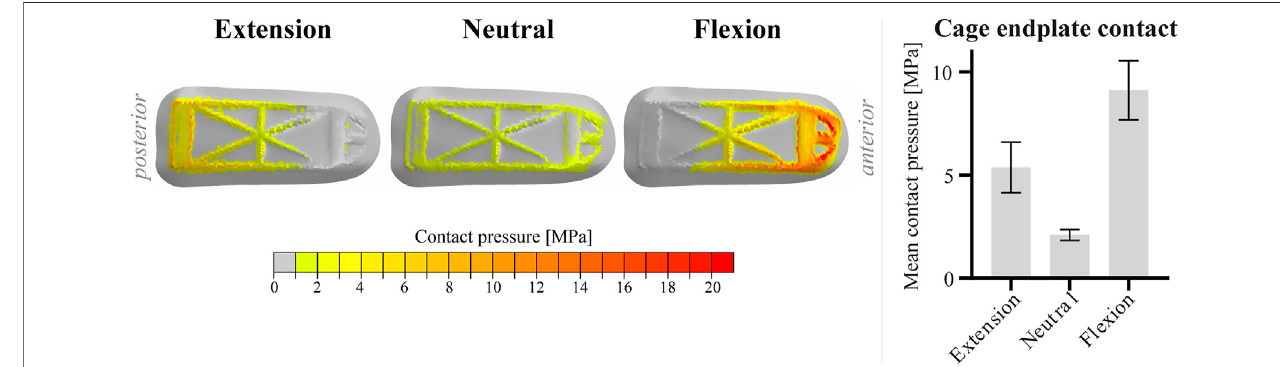
FIGURE4| Visualizationofthecontactpressureoftherightcageofpatient1onthecaudalcontactlayerinextension,neutraland fl exionposition.Forthebarchart, dataofthetwocaudalcontactlayerswithinonepatientwereamalgamated.Thebarchartdisplaysthemeancaudalcontactpressureforthedifferentloadingconditions. Bars represent the mean and 95% con fi dence interval of the patient population (n (cid:1)